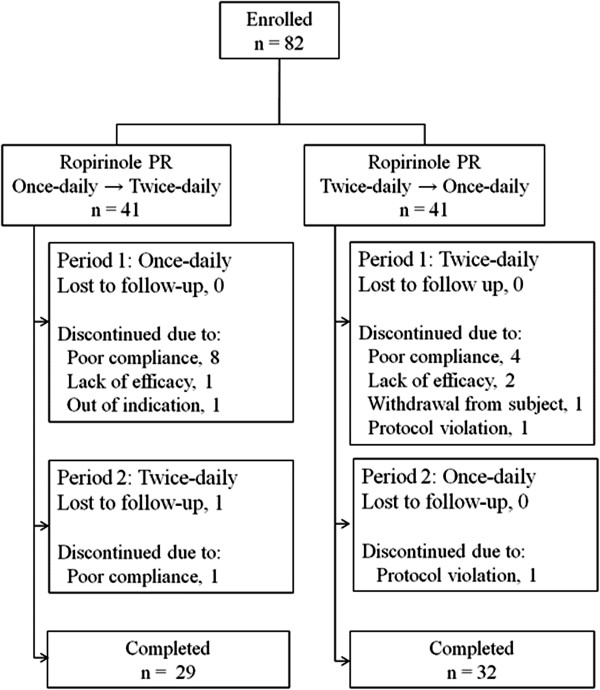
Subject flow chart.